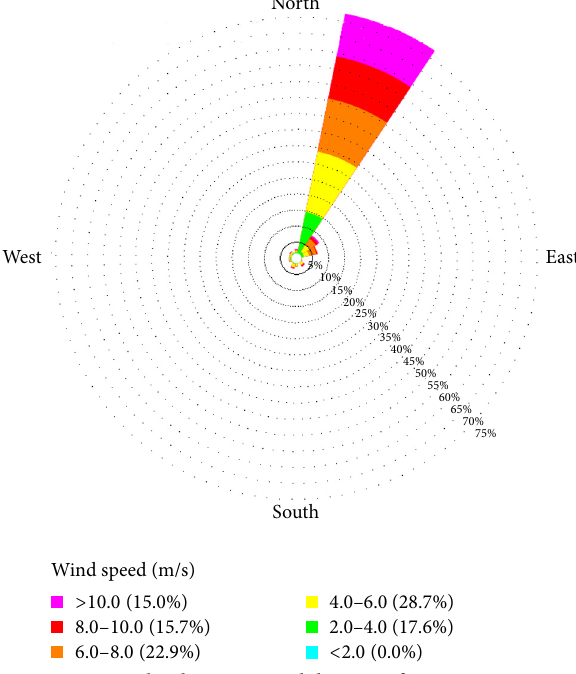
Figure 8: Polar diagram: wind direction for Faya-Largeau.